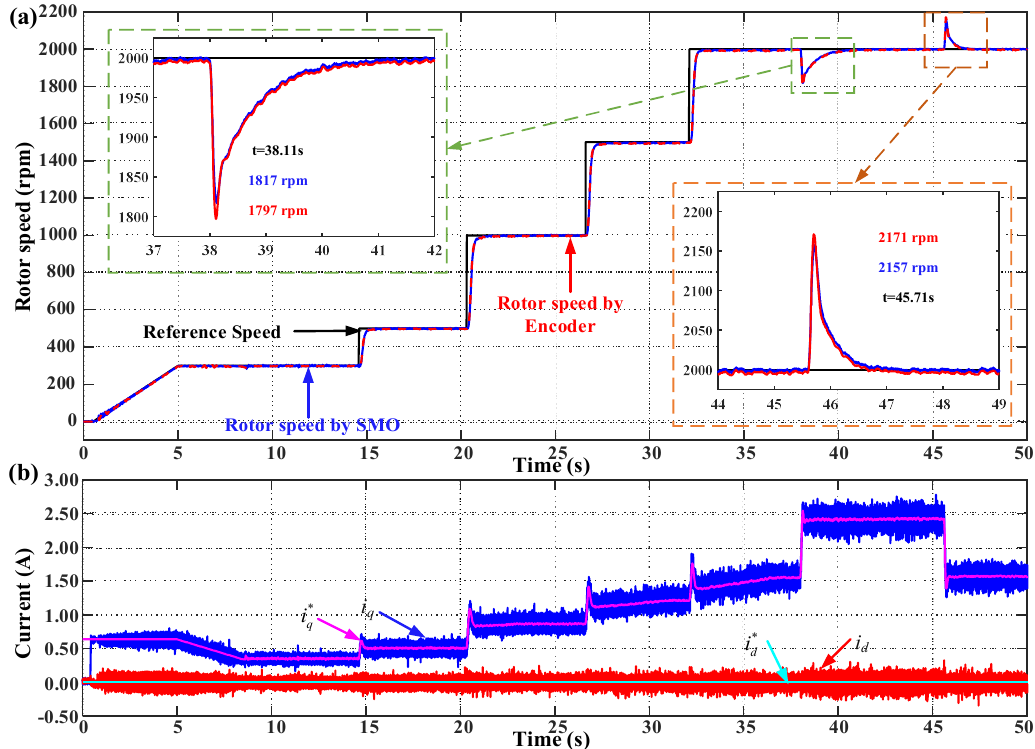
Figure 16. Experimental results in the case of the varied external load (RL = 100 ↔ 50 Ω) at 2000 rpm for ( a ) speed response, ( b ) current response.